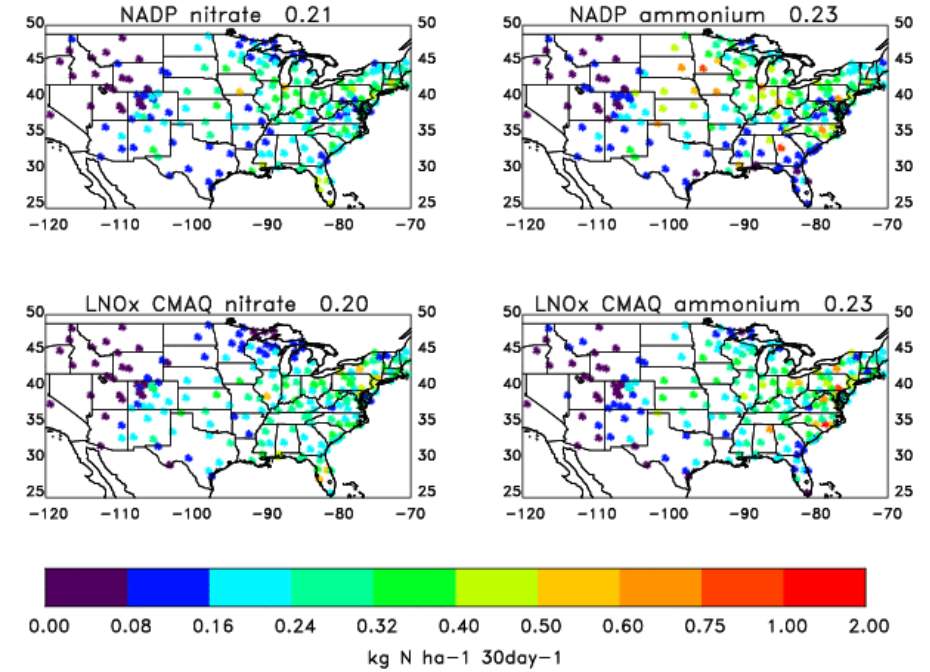
Figure 11. Summer 2006 wet deposition of nitrogen at NADP/NTP sites. Upper left: Fig. 11. Summer 2006 wet deposition of nitrogen at NADP/NTP sites. Upper left: nitrate measurements, upper right: ammonium measure- nitrate measurements, upper right: ammonium measurements, lower left: nitrate from ments, lower left: nitrate from simulation LNO x , and lower right: ammonium from simulation LNO x . , and lower right: ammonium from simulation LNO simulation LNO x